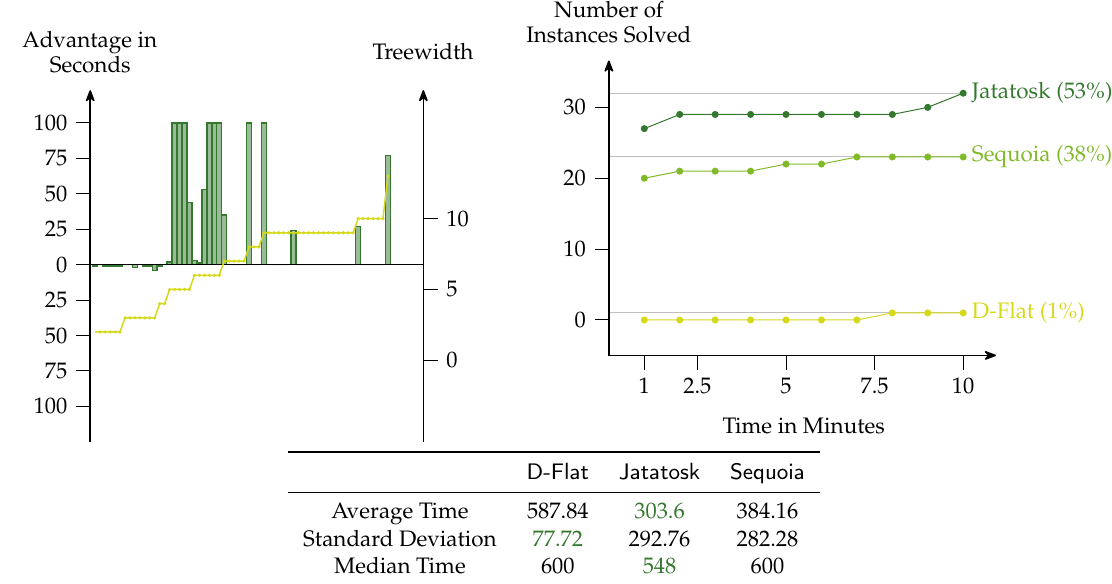
Figure 6. Experiment for the FEEDBACK - VERTEX - SET problem.